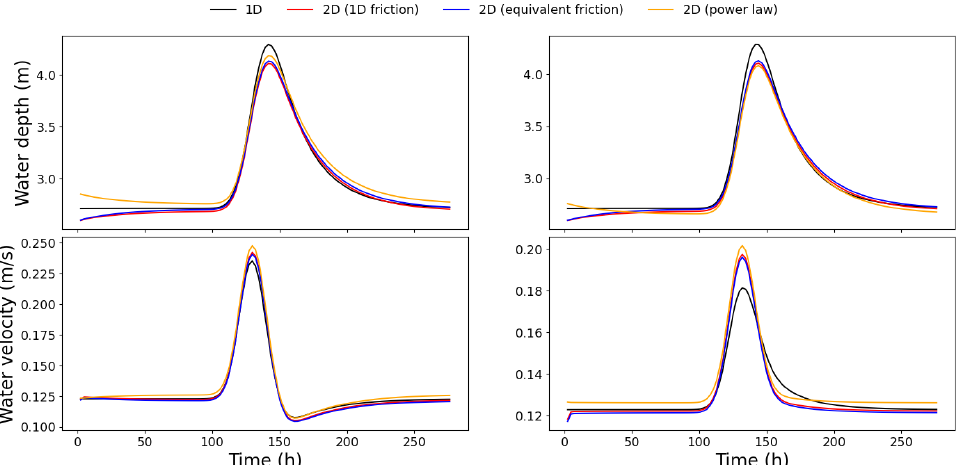
Figure 9. Effective friction analysis for an unsteady waterline in case (i). The power law is given by n = αh β , with α = 0 . 0446 and β = 0 . 0634. The injected hydrograph is symmetrical. observation stations are at x = 2 . 5km and x = 7 . 5km. Adaptive time step with average value of 13s. One-dimensional-like cell length: 200m. Average Courant number: 0 .